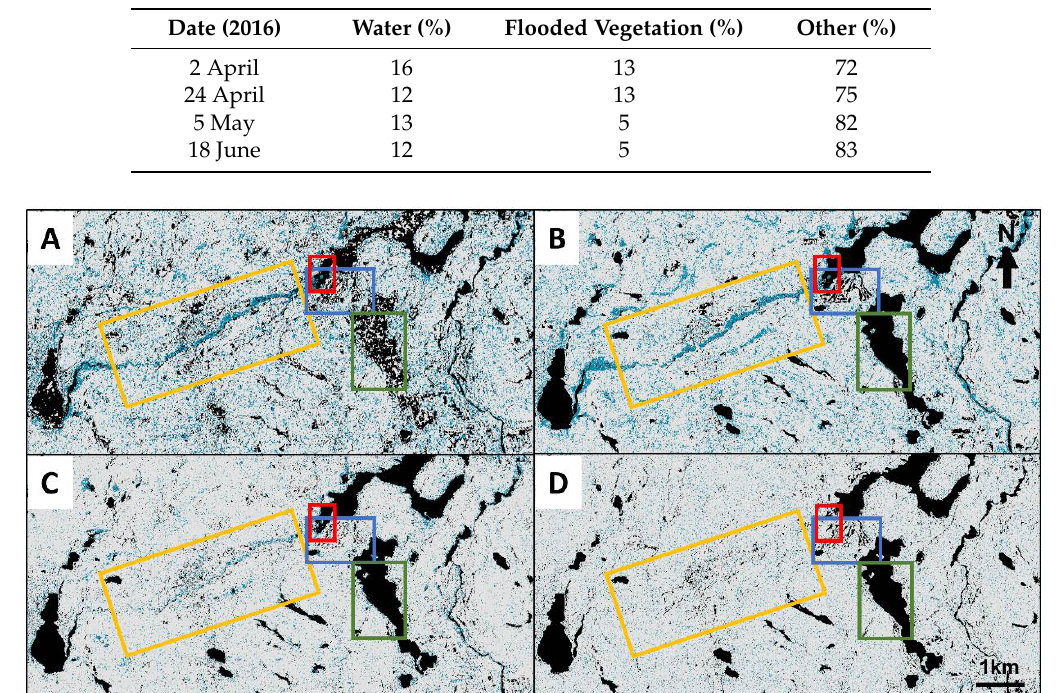
Figure 10. Kennaugh Element models classified showing water (black), flooded vegetation (blue), and other (grey) for ( A ) 2 April 2016; ( B ) 24 April 2016; ( C ) 5 May 2016; and ( D ) 18 June 2016. Coloured boxes indicate example areas of change: blue—golf course misclassified as water; red—marshland dries with time; yellow—flooded vegetation decrease, and misclassification of field areas; green—ice melting.